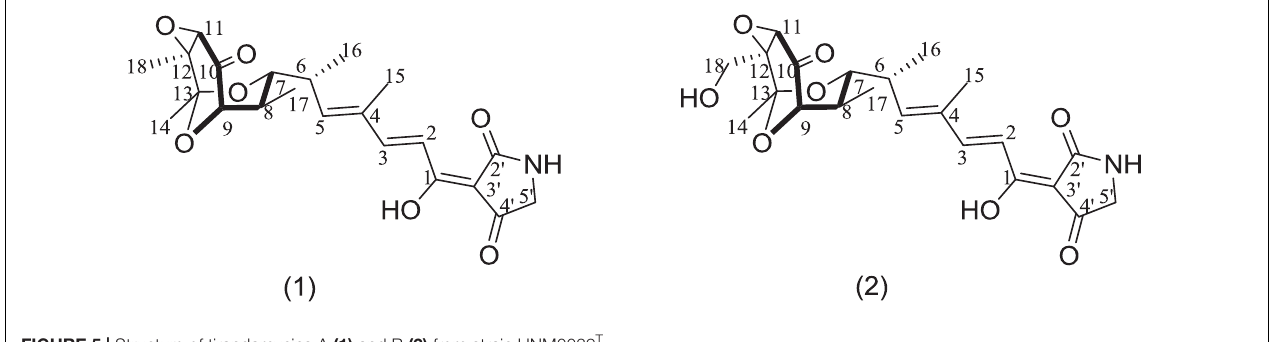
FIGURE 5 | Structure of tirandamycins A (1) and B (2) from strain HNM0039 T .